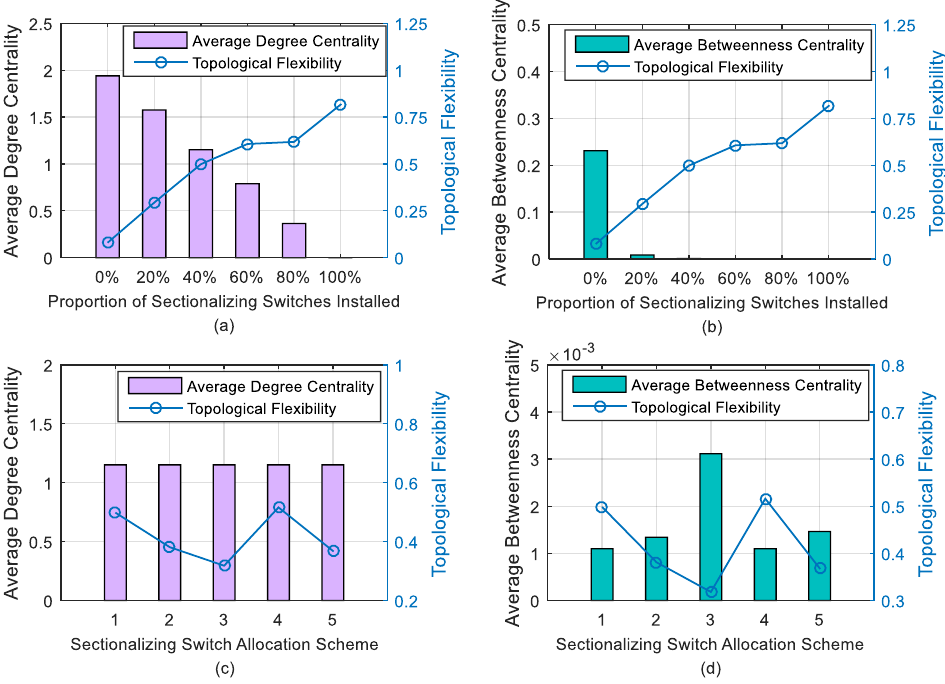
Figure 6. Distribution network topological flexibility, average degree centrality, and average betweenness centrality based on the change of sectionalizing switches. ( a ) Topological flexibility and average degree centrality with the different number of sectionalizing switches; ( b ) topological flexibility and average betweenness centrality with the different number of sectionalizing switches; ( c ) topological flexibility and average degree centrality with different allocation schemes based on the same number of sectionalizing switches; ( d ) topological flexibility and average betweenness centrality with different allocation schemes based on the same number of sectionalizing switches.